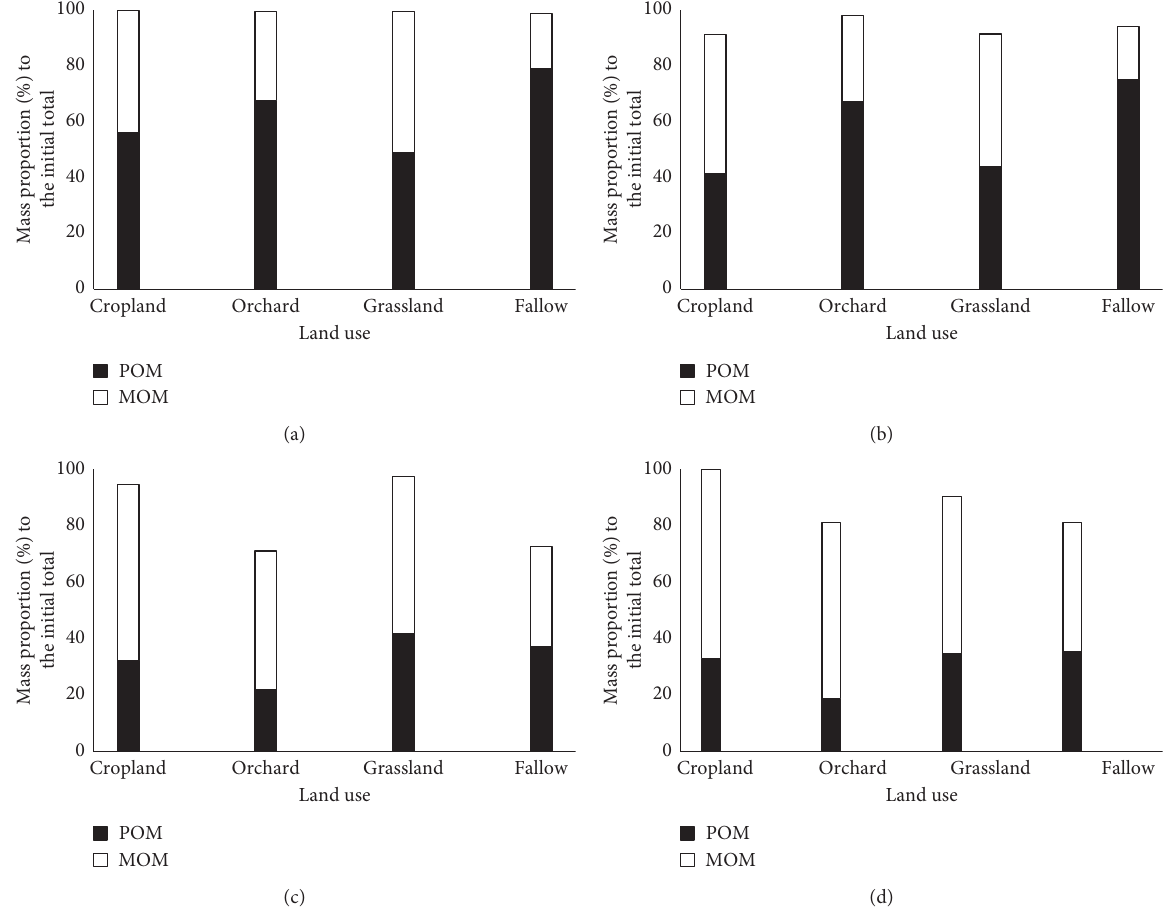
Figure 3: Mass proportion of the physical fractions (POM (particulate organic matter) ≥ 53 µ m and MOM (mineral associated organic matter) ≤ 53 µ m.) to the initial total soil of four agroecological zones (AEZs: (a) � AEZ-7, (b) � AEZ-3, (c) � AEZ-9, and (d) � AEZ-5) used in fractionation for different land Table 3: Mean values of organic carbon (OC), nitrogen (N) and C : N ratio in physical fractions of soils from four agroecological zones under four land use types.